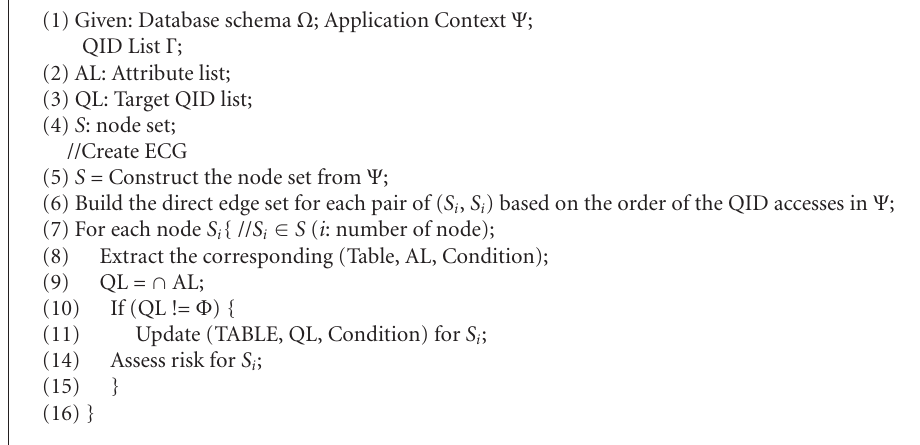
Algorithm 1: ECG composer algorithm.